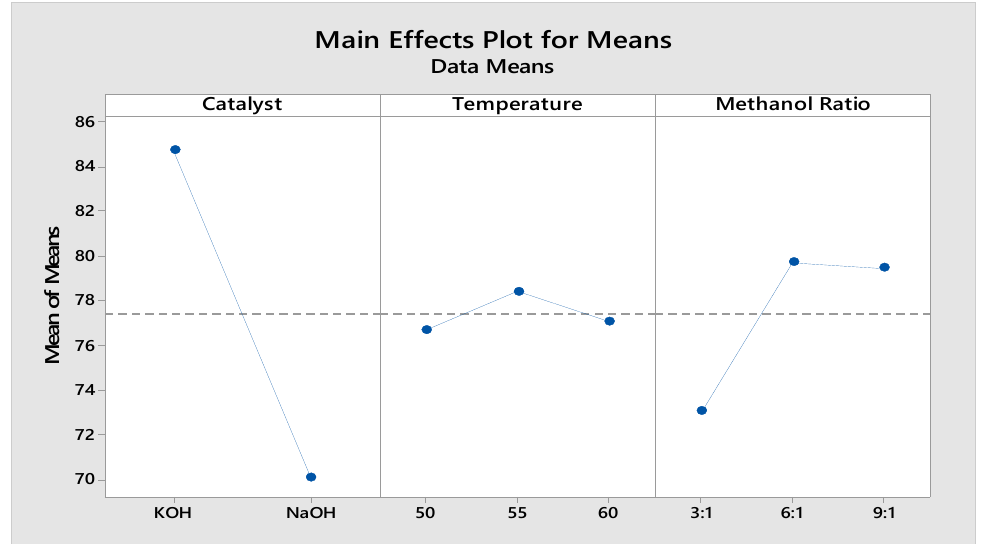
Figure 5. Plot of model experiment: means versus catalyst, temperature and methanol ratio.